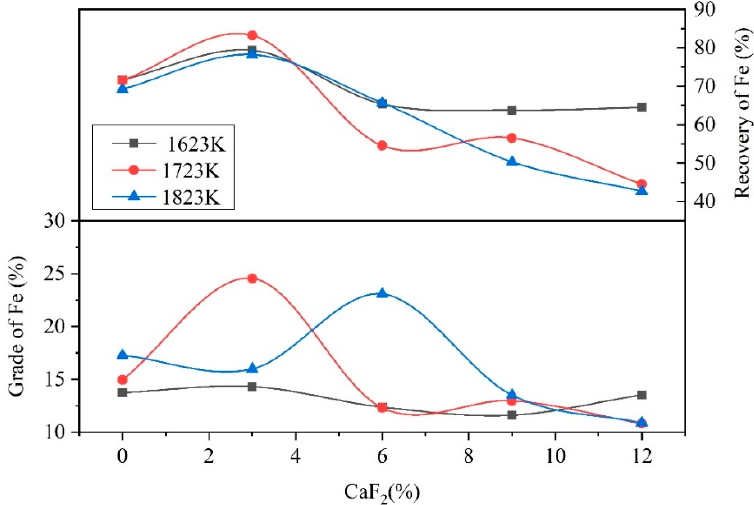
Figure 13. The effect of additives and temperature on Fe enrichment (%), the upper three lines in the figure represents the recovery of Fe, and the lower three lines in the figure represents the grade of Fe.